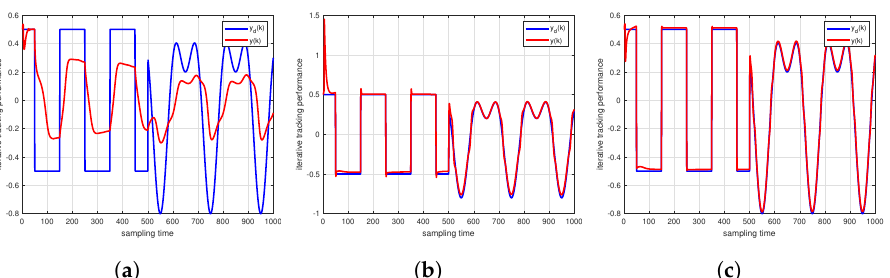
Figure 4. Performance for different iterations. ( a ) The tracking performance for the 10th iteration. ( b ) The tracking performance for the 50th iteration. ( c ) The tracking performance for the 100th iteration.